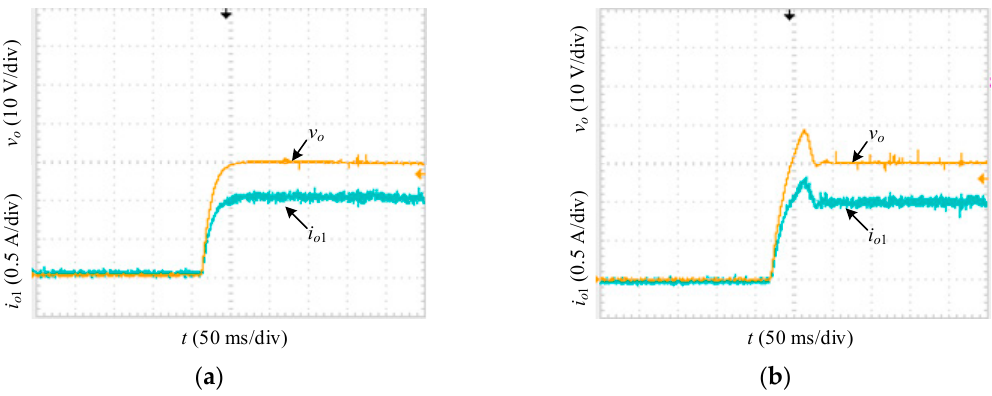
Figure 14. Startup waveforms of a buck–boost converter with a pure resistive load and a CPL connected in parallel: ( a ) inverse-system decoupling controller; ( b ) conventional double closed-loop controller.